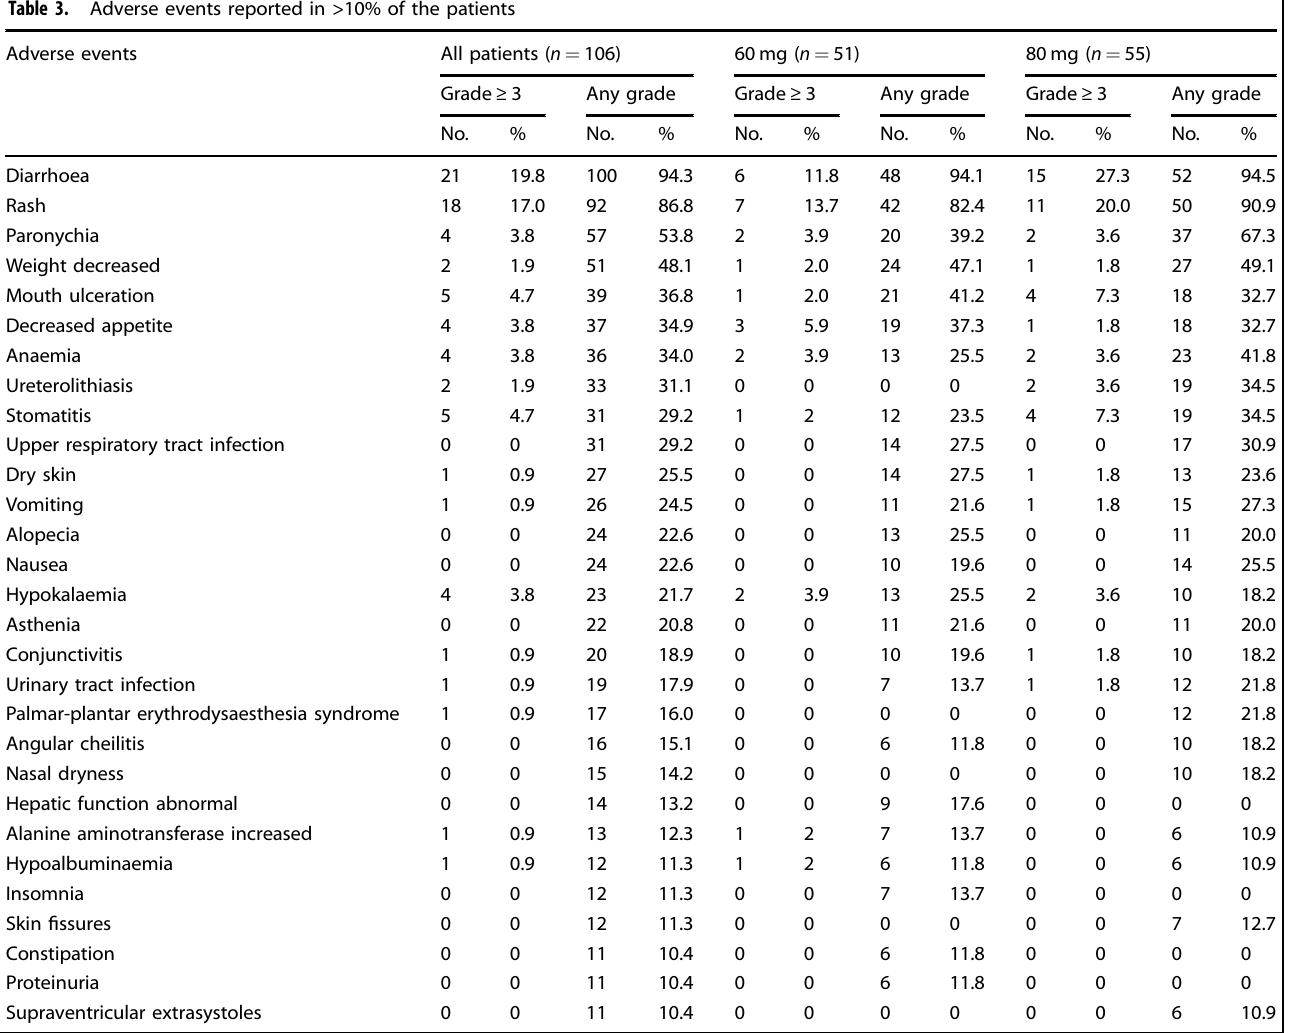
Table 3. Adverse events reported in >10% of the